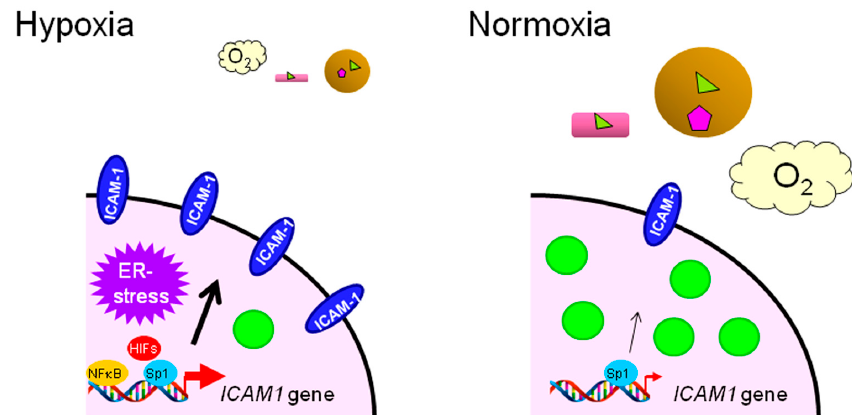
Figure 4. Model of ICAM1 induction in ovarian cancer cells exposed to LCFA deficiency and hypoxia (left schematic). Expression of the ICAM1 gene is robustly enhanced (a bold red bent arrow) under this stress condition, leading to high ICAM-1 expression on the cell surface (a black bold arrow). ER stress is also induced in cancer cells; however, it is not responsible for this transcriptional activation. In contrast, ICAM1 expression is relatively low in cancer cells exposed to normoxia (right schematic). The LD level in these cells is relatively high owing to a sufficient LCFA supply.